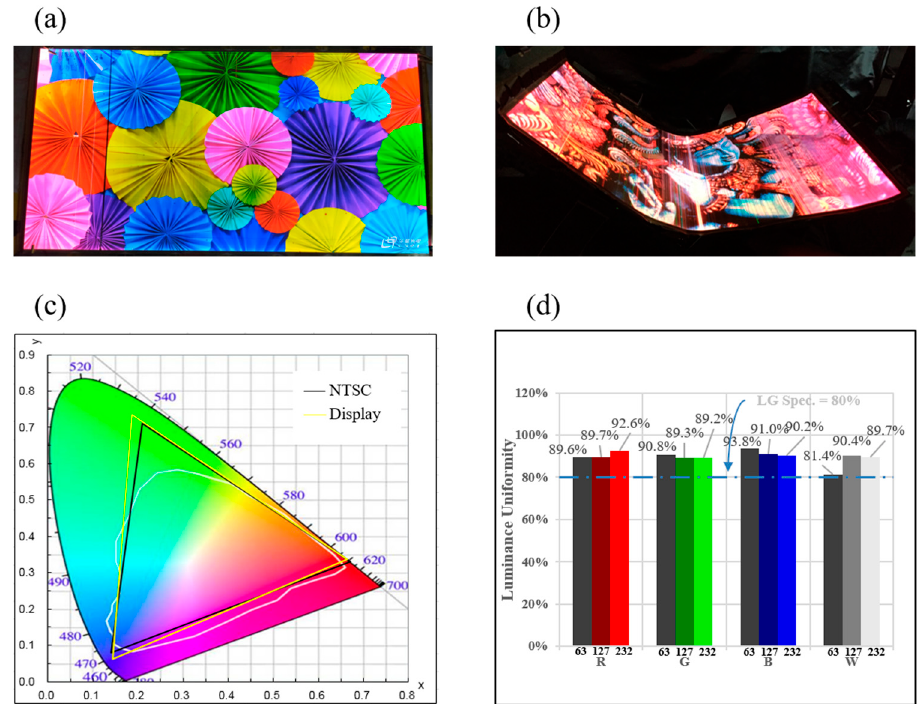
Figure 8. The image of 31-inch 4K AMOLED display on ( a ) PI/glass template; ( b ) PI template; ( c ) CIE color coordinate of the AMOLED display; ( d ) the brightness difference over the